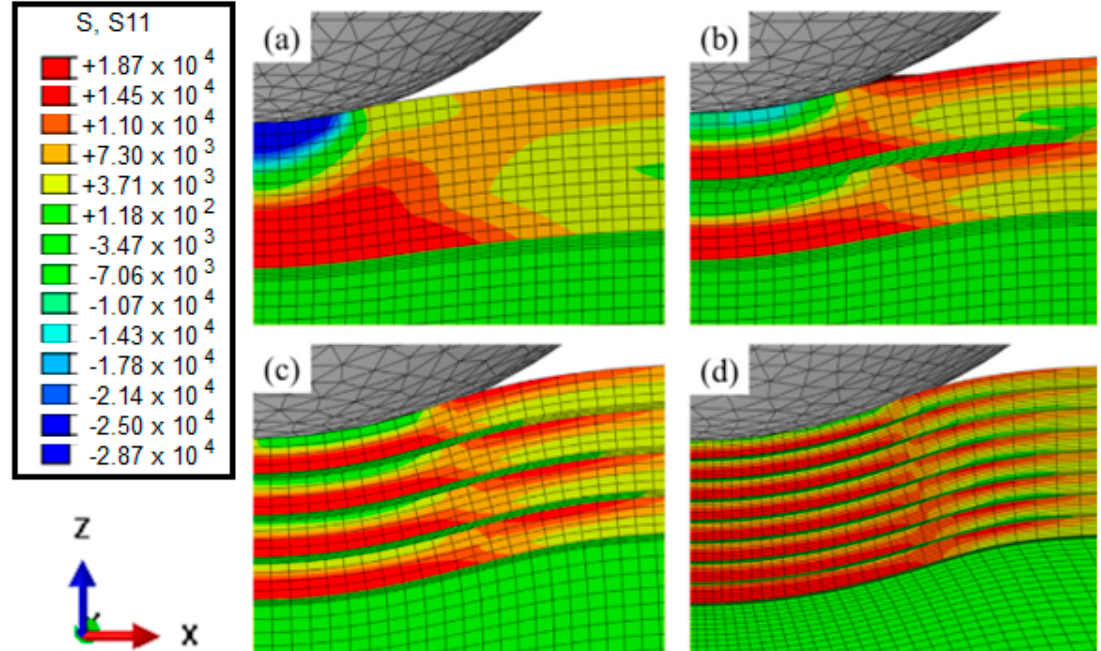
Figure 12. Stress fields in the 16 μ m TiN coating ( a ) and the 16 μ m TiN/Ti multilayer coatings with the bilayers number of ( b ) N = 2, ( c ) N = 4 and ( d ) N = 8 deposited on Ti-6Al-4V alloy by combining the techniques of a filtered cathode vacuum arc and a metal vapor vacuum arc ion implantation, reprinted from Surface and Coatings Technology , Reference [16], with permission from Elsevier.